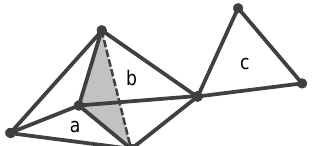
Figure 4. Three simplices of dimension 3 ( a and b ) and 2 ( c ). Simplices a and b are 2-near because they share a face; simplices b and c are 0-near because they share one vertex;